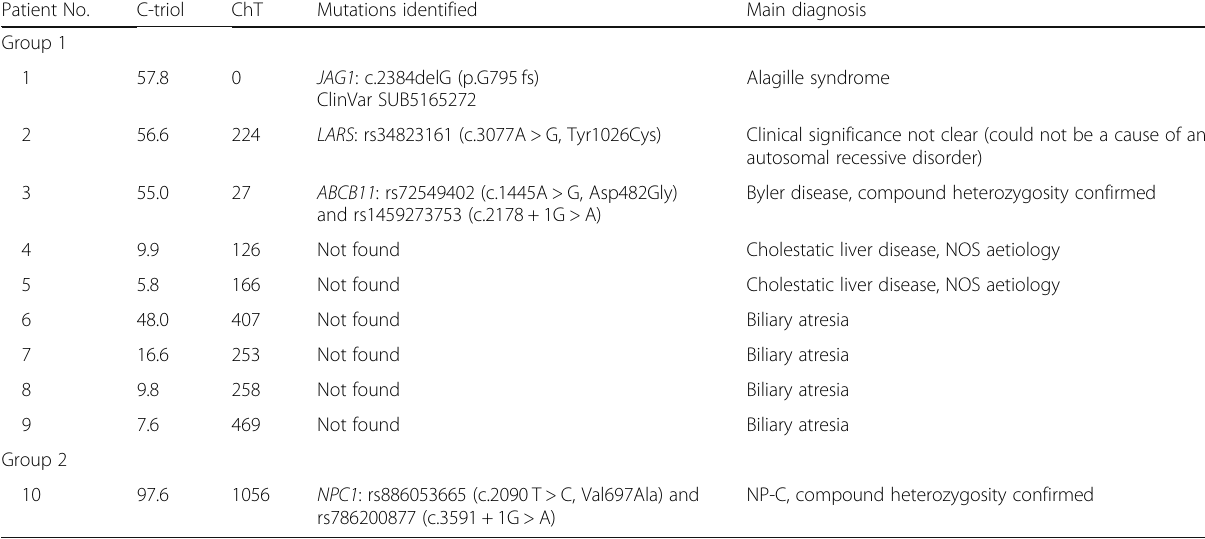
Table 3 Mutations and diagnoses among children with elevated plasma C-triol and/or ChT Patient No.